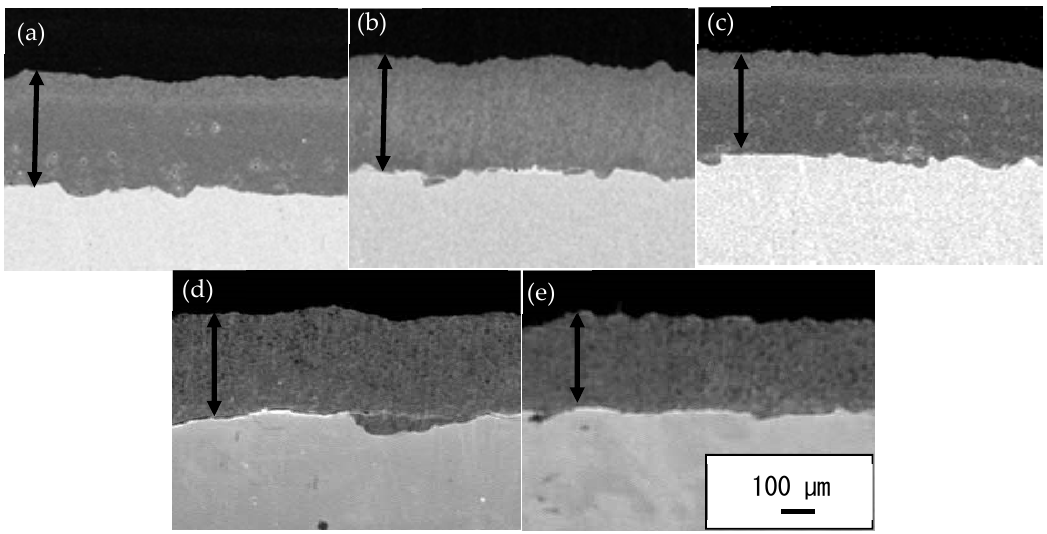
Figure 4. Cross-section microstructure of TiO 2 coatings on SUS 304. ( a ) Room temperature; ( b ) annealed at 300 ◦ C; ( c ) annealed at 500 ◦ C; ( d ) annealed at 700 ◦ C; and ( e ) annealed at 1000 ◦